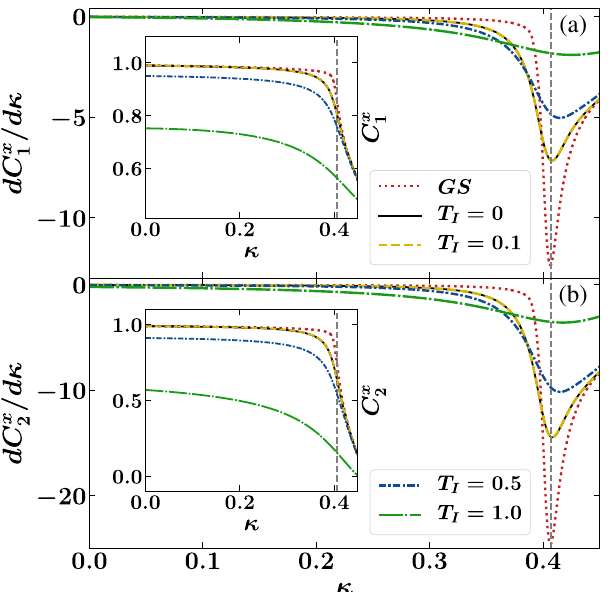
FIG. 6. The nearest- (next-nearest-) neighbor longitudinal spin- spin correlation per site C x 1 ( C x 2 ) [see Eq. (3)], evaluated in thermal equilibrium using NLCE following quenches κ ¼ 0 → κ , with T ¼ 0 , 0.1, 0.5, and 1.0. We also show C x I I ˆ H ð κ Þ and C x 2 in the ground state of (dotted lines) computed using iTEBD. The main figures in (a) and (b) show dC 1 =d κ and dC =d κ , respectively, while the corresponding insets show C x 2 and C x 2 . The vertical dashed lines mark the critical κ c ≈ 0 . 41